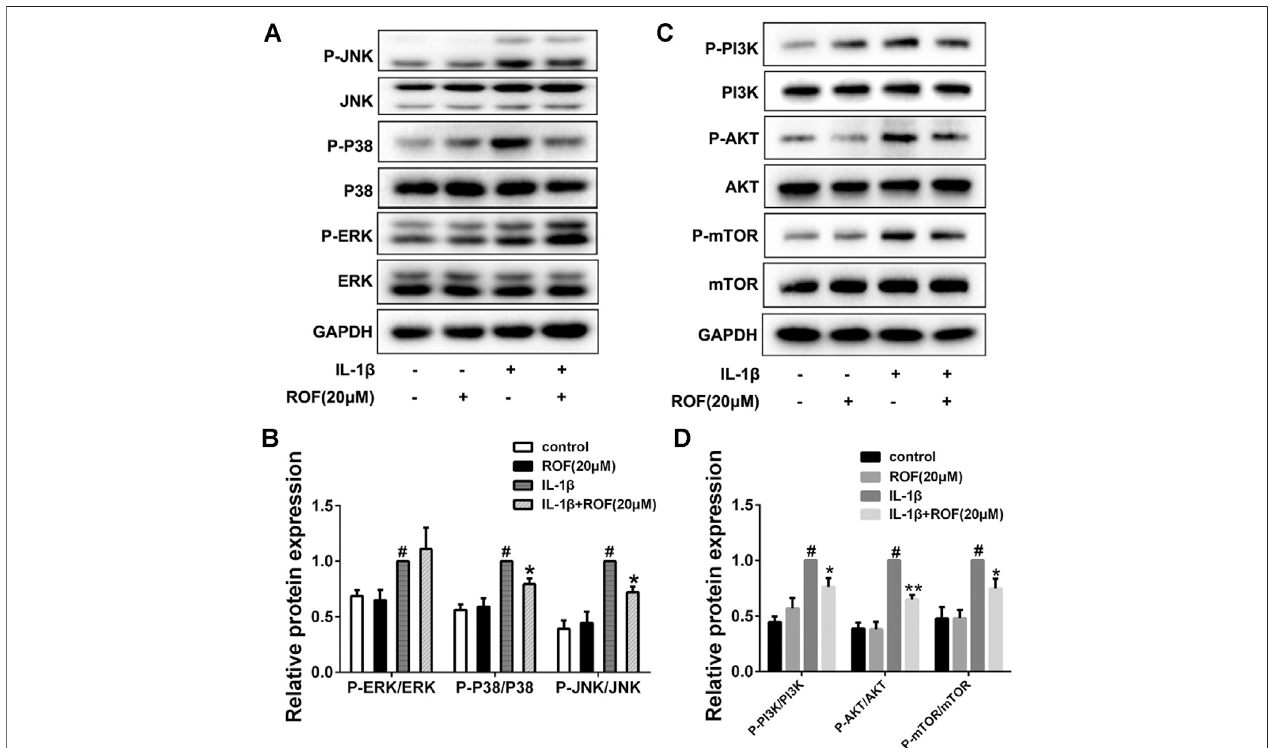
FIGURE 5 | ROF blocks the activation of P38/JNK and PI3K/AKT/mTOR pathways induced by IL-1 β in chondrocytes. Cells were exposed to L-1 β (10 ng/ml) with or without 20 μ M ROF for 30 min as above. (A) Western blots and (B) quantitative analysis of MAPK pathways in each group. (C) Western blots and (D) quantitative analysisofPI3K/AKT/mTORpathwaysineachgroup.JNK,P38,ERK,PI3K,AKT,andmTORwereusedasloadingcontrol( n (cid:2) 3).# p < 0.05vs.controlgroup;* p < 0.05 and ** p < 0.01 vs. IL-1 β